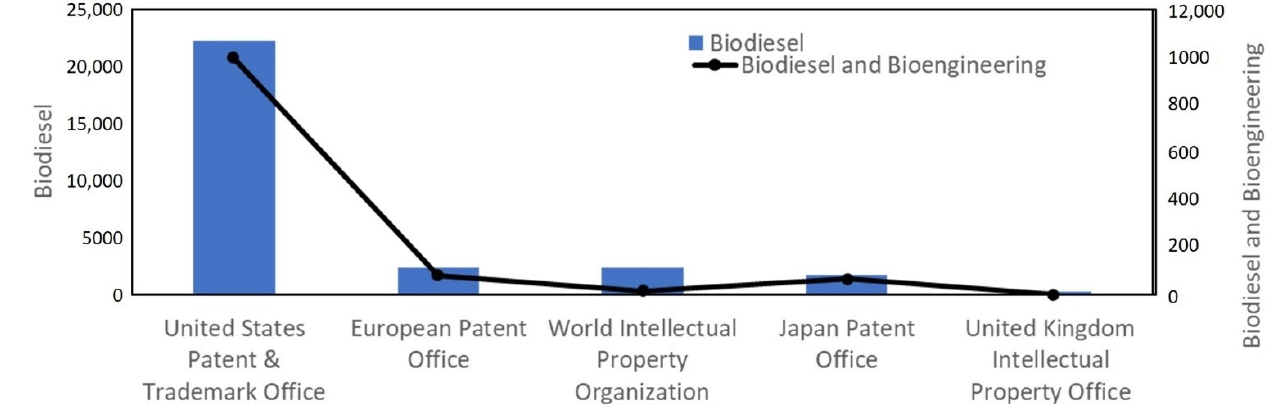
Figure 3. Different types of publications with keywords ‘biodiesel’ and ‘biodiesel and bioengi- neering’.